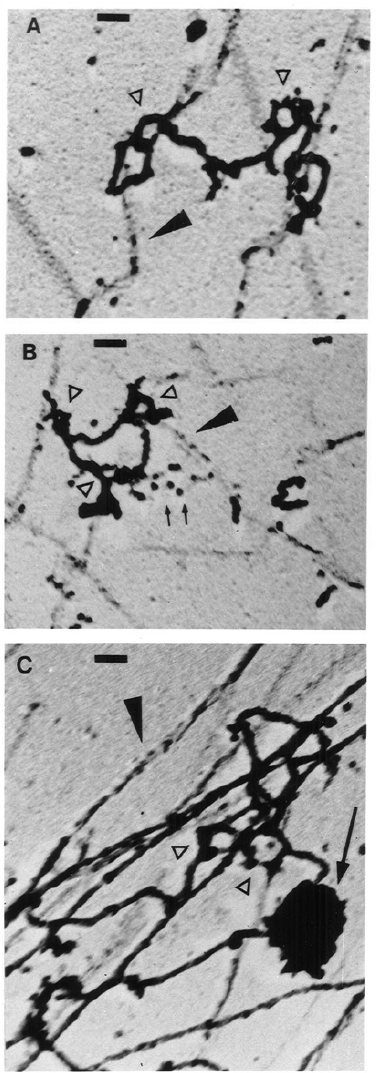
Fig. 5 – A patch of thefibrous network (large arrowhead) showing filaments with RNP particles connecting NPCs (4n; spread of isolated nuclei; aqueous uranyl acetate; bar = 180